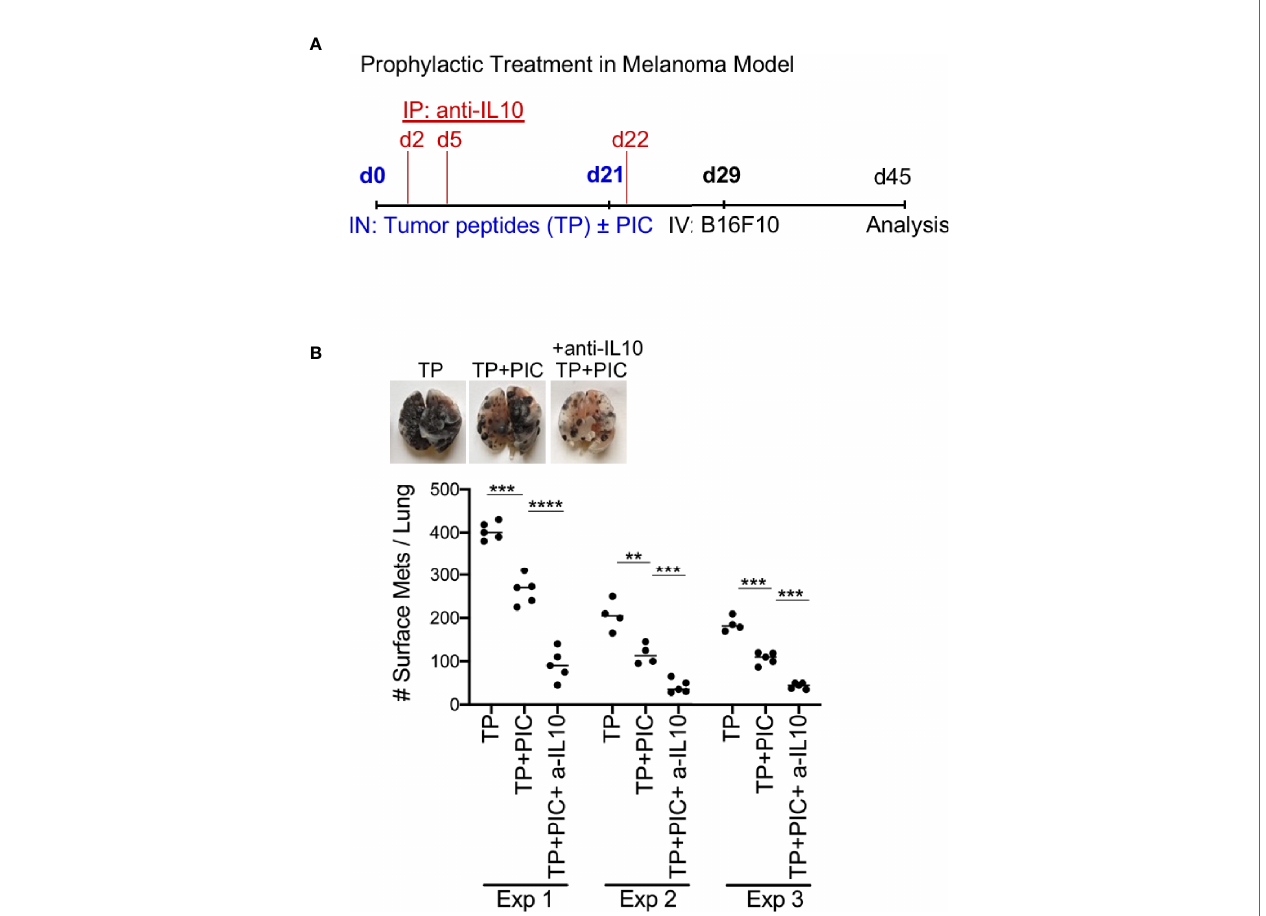
FIGURE 6 | Immunization with B16F10 Peptides (TP) +Poly IC +anti IL-10 subunit vaccine produces anti-tumor effect in metastatic B16F10 melanoma model. (A) Schematic protocol for vaccination and B16F10 i.v. injection in WT mice for anti-tumor effect. (B) WT with TP (peptides) only, with TP +Poly IC and with TP +Poly IC +anti-IL-10 were harvested after i.v. B16F10 challenge and mouse lungs were in fl ated. Pics depict total surface metastases (mets) per lung (top), which were enumerated and illustrated by scatter plot, each dot represents one mouse (bottom). Combined data of three independent experiments with 4-5 mice per group. Data are shown as mean ± SEM. ****P value < 0.0001. *** P < 0.001. **P <